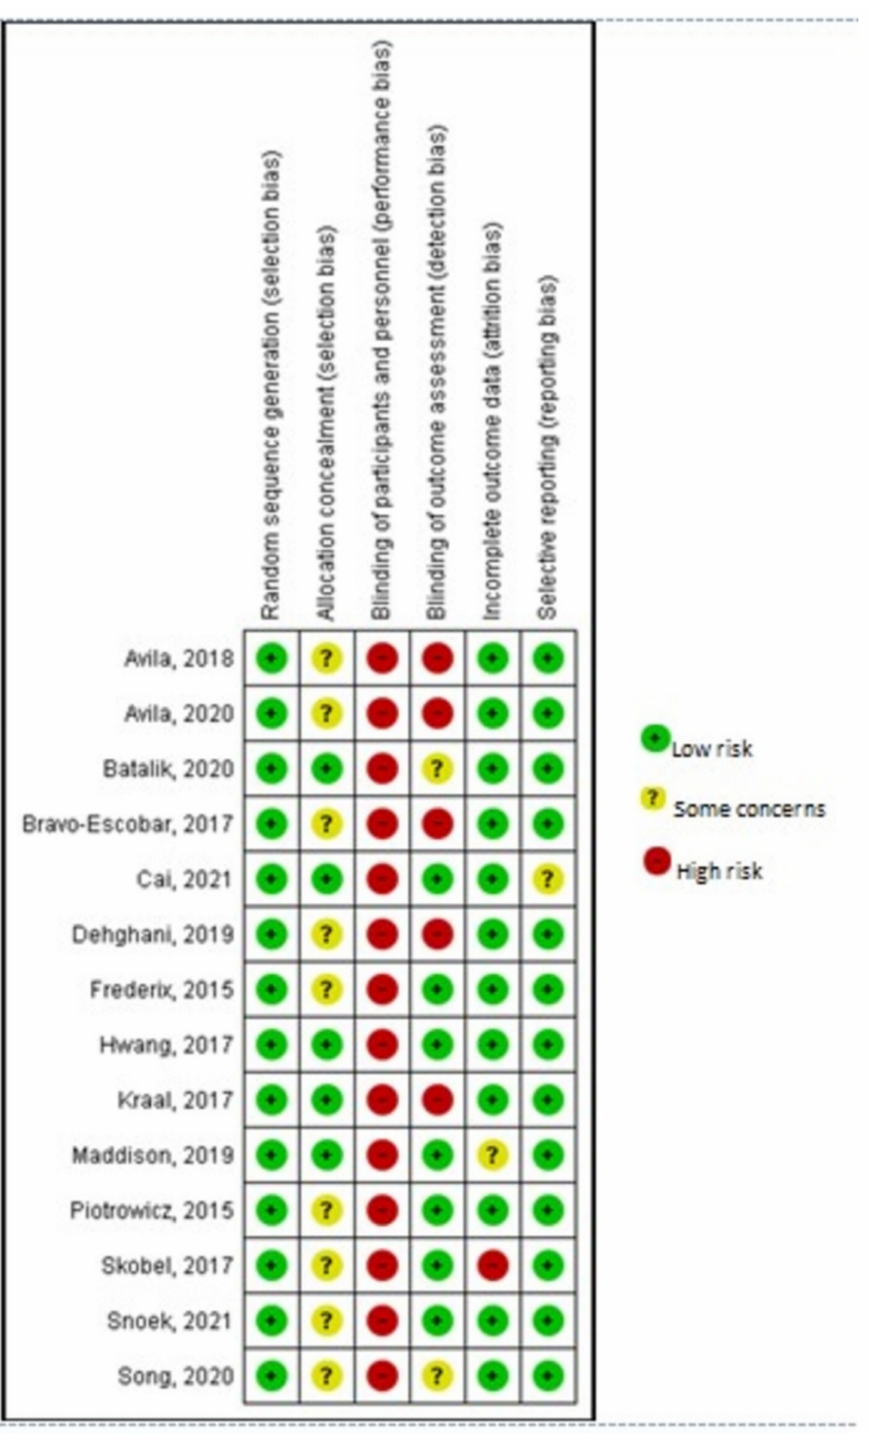
Figure 2. Risk of bias summary. Avila, 2018 [42]; Avila, 2020 [41]; Batalik, 2020 [40]; Bravo-Escobar, 2017 [38]; Cai, 2021 [30]; Dehghani, 2019 [43]; Frederix, 2015 [34]; Hwang, 2017 [32]; Kraal, 2017 [33]; Maddison, 2019 [31]; Piotrowicz, 2015 [35]; Skobel, 2017 [37]; Snoek, 2021 [36]; Song, 2020